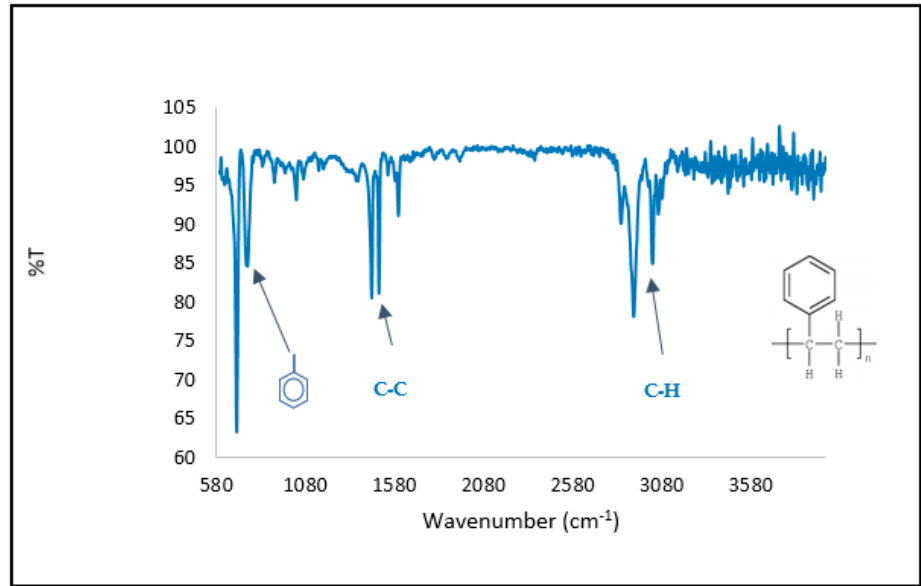
Figure 2. FTIR spectroscopic results of the plastic sample.